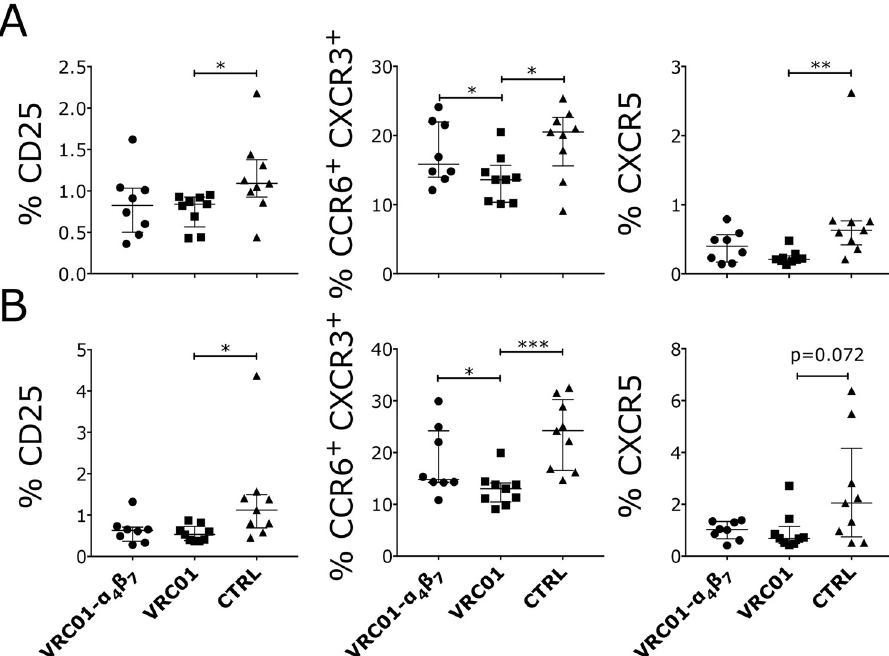
Fig 4. Decreased frequencies of CD25 + , CCR6 + CXCR3 + and CXCR5 + T cells in the lymph nodes of VRC01-pretreated, SHIV-infected macaques. (A-B) At necropsy, cells were isolated from inguinal lymph nodes and analyzed by flow cytometry. The frequencies of subsets within the CD4 + (A) and CD4 - (B) T cells that were significantly different in any of the treatment groups compared to the controls by Kruskal-Wallis test are shown. Cells from 1 animal (HB73) in the VRC01-Rh- α 4 β 7 group were lost during data acquisition. The results of the Dunn’s multiple comparisons post-hoc test and the Mann-Whitney test to compare the treatment groups between each other are shown ( p -value of � α < 0.05, �� α < 0.01 and ��� α < 0.001 were considered significant). Bars represent median ±